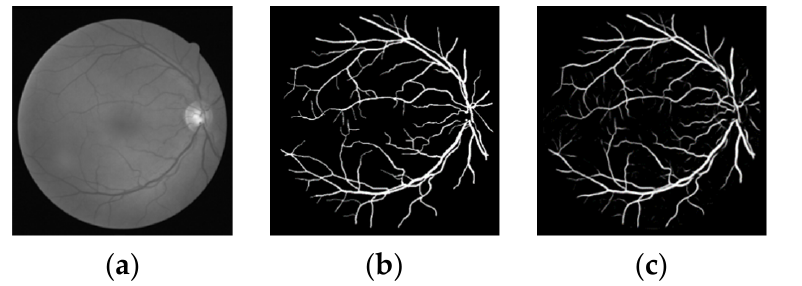
Figure 6. First group of segmentation results ( a ) original image ( b ) gold standard image ( c ) segmen- tation results of this paper.